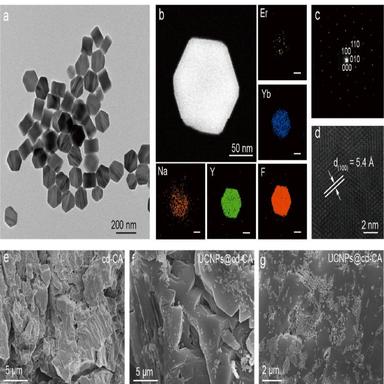
a) Bright-field TEM image of β-NaYF4: Yb, Er UCNPs, b) dark-field TEM image of a single β-NaYF4: Yb, Er UCNP and the corresponding elemental mapping (scale bar: 50 nm), c) selected area electron diffraction pattern and d) lattice fringes of the β-NaYF4: Yb, Er UCNP shown in panel b (scale bar: 2 nm), and e) SEM images of cd-CA and f, g) UCNPs@cd-CA.